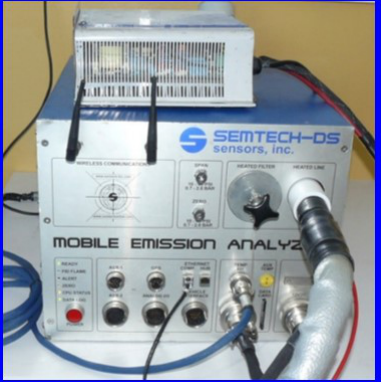
Figure 4. SEMTECH DS gaseous emission analyzer.